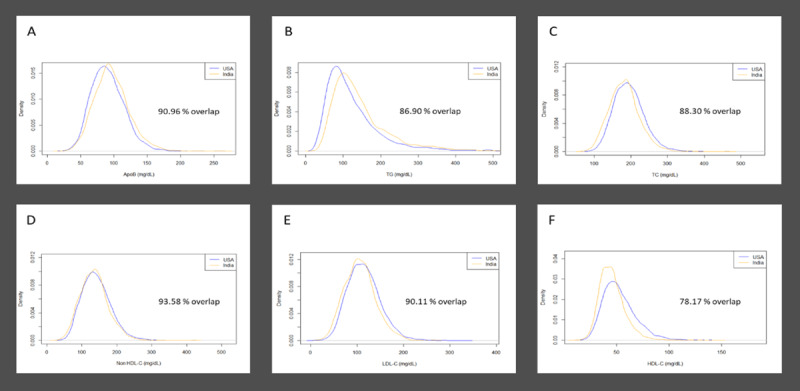
Density Plots for the lipid biomarkers. A: ApoB = apolipoprotein B mg/dL; B: TG = triglycerides mg/dL; C: TC = total cholesterol mg/dL; D: Non-HDL-C = total cholesterol mg/dL – high-density lipoprotein cholesterol mg/dL; E: LDL-C = low-density lipoprotein cholesterol mg/dL; F: HDL-C = high-density lipoprotein cholesterol mg/dL; USA = United States of America.